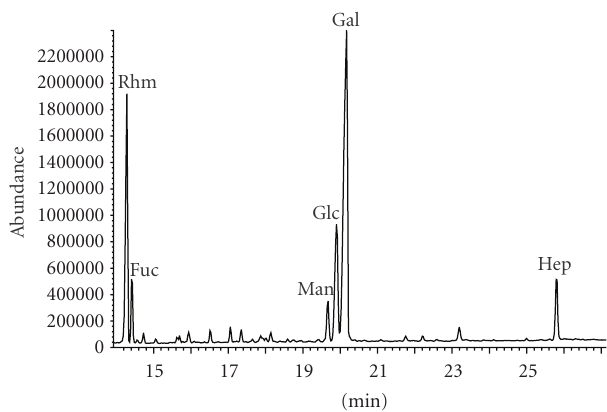
Figure 2: Chromatogram of alditol acetates derived from the core and O-antigen of D. desulfuricans